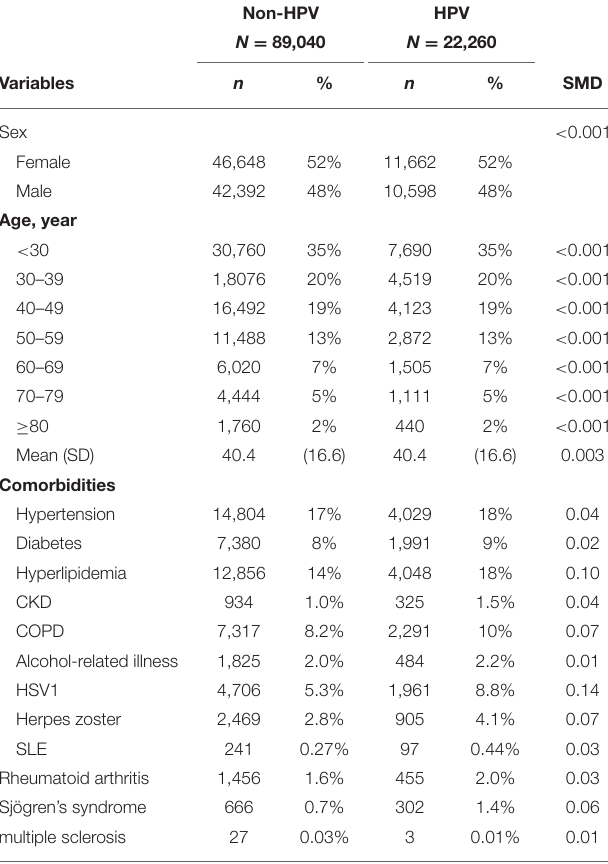
TABLE 1 | Baseline patient